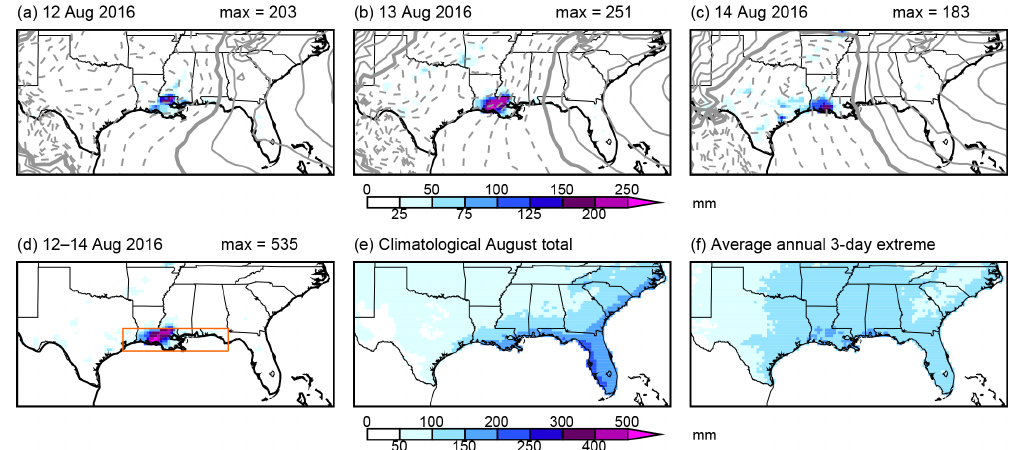
Figure 1. (a, b, c) Daily precipitation (shaded colors) and sea level pressure (grey contours, interval 1hPa, 1015hPa contour thickened, lower contours dashed) for 12, 13 and 14 August 2016. (d) The 3-day precipitation sum for 12–14 August 2016. (e) August climatological total precipitation (1948–2015). (f) Average annual maximum 3-day precipitation event (1948–2015). Orange box in (d) shows the geographic region used for the analysis (29–31 ◦ N, 85–95 ◦ W). Data are from CPC unified gauge-based analysis of daily precipitation over the contiguous US (2016 data are from the real-time archive) and ECMWF operational analysis.